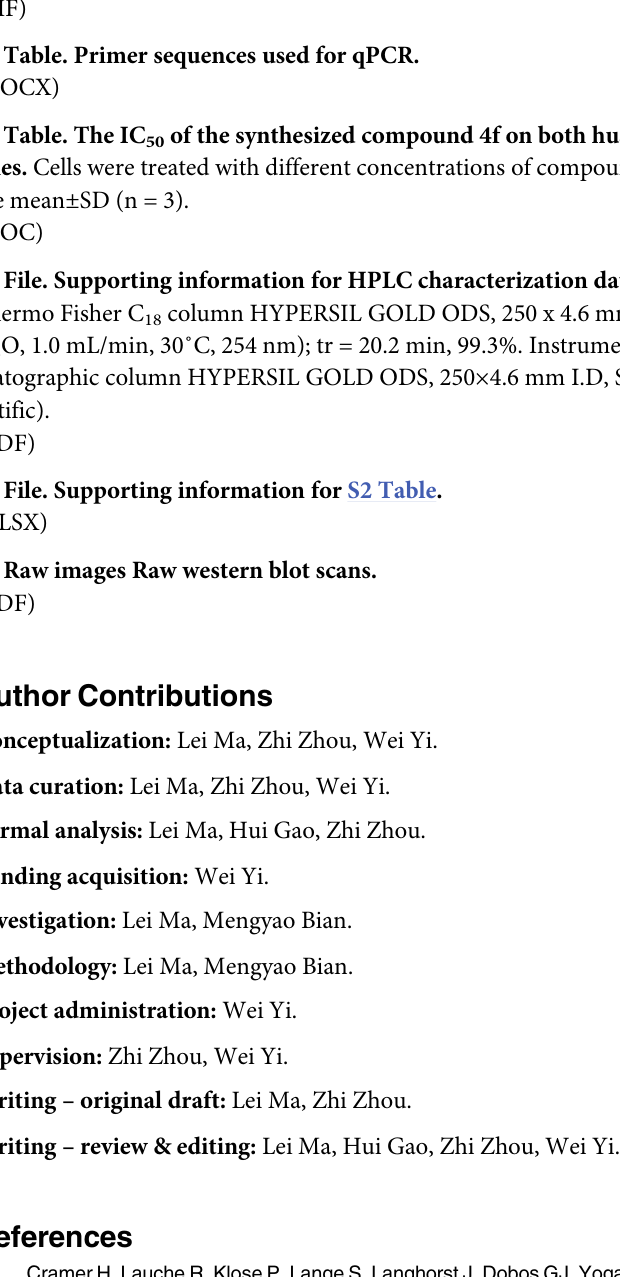
values are 50 chro- 18